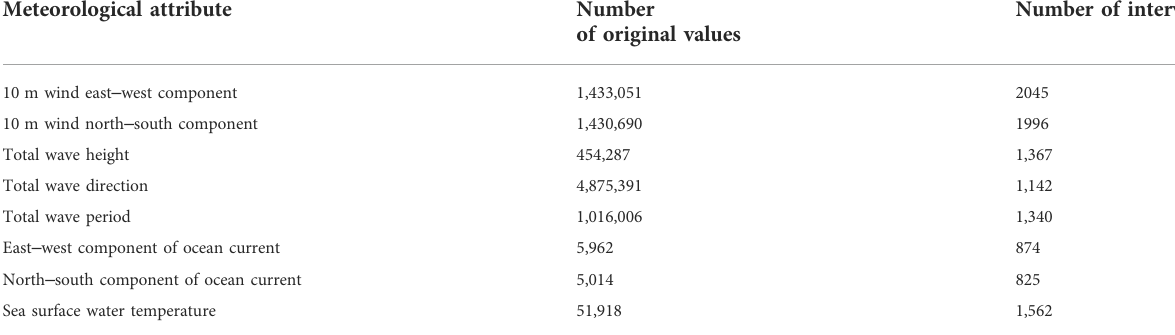
TABLE 3 The number of discrete intervals of meteorological